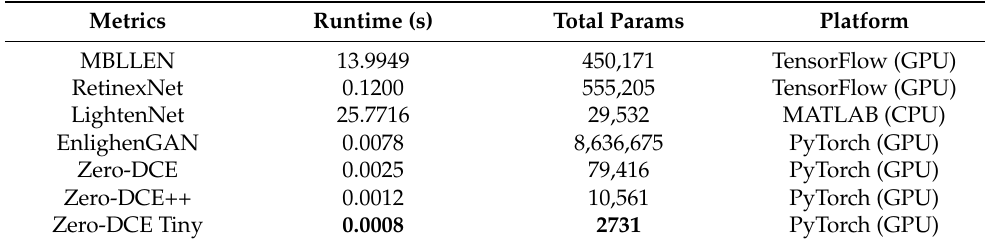
Table 4. Model running speed